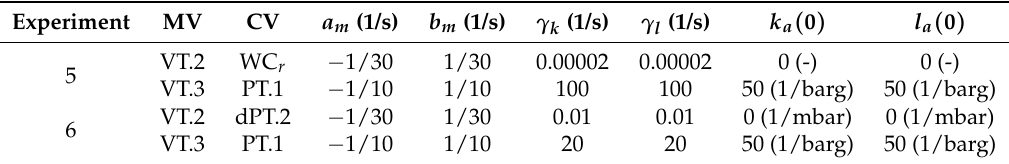
Table 6. Model reference adaptive controller (MRAC) parameter